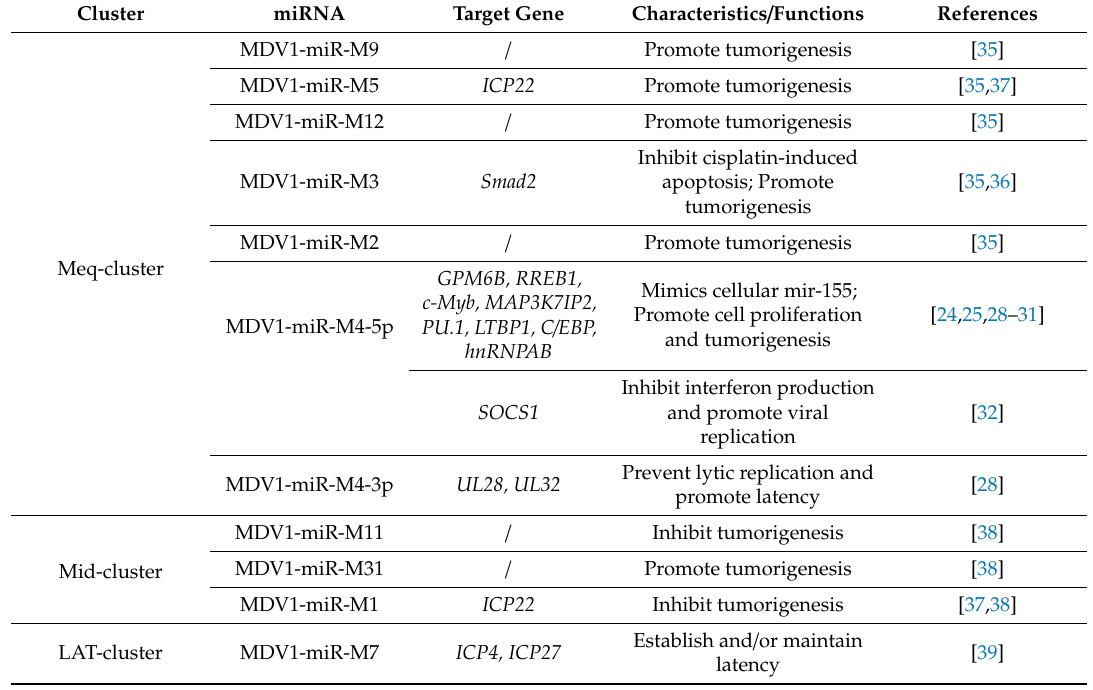
Table 1. The role of Marek’s disease virus (MDV)-1 encoded miRNAs summarized in this review.